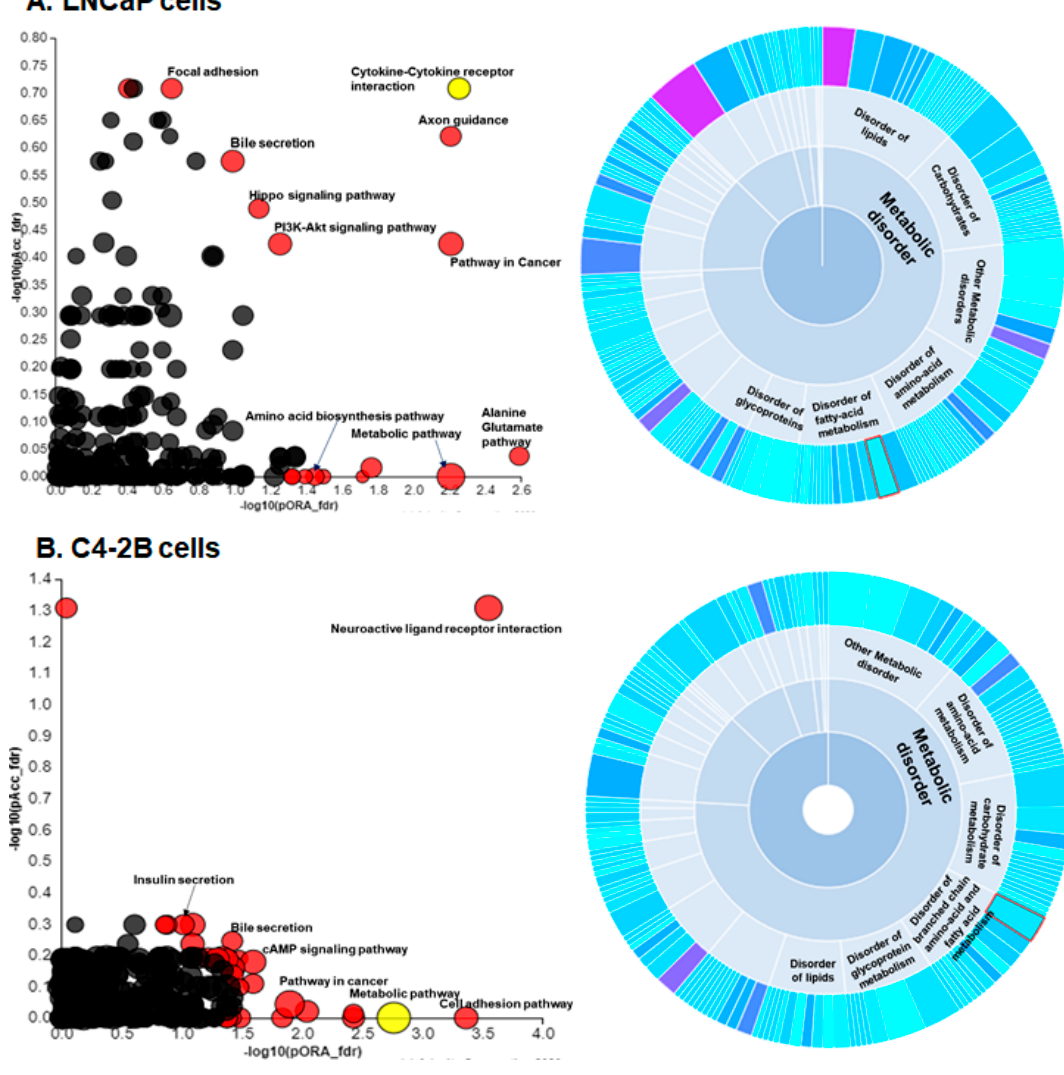
Figure 3. Pathway enrichment analysis of disease association in ( A ) LNCaP enzalutamide resistant cells and ( B ) C4-2B enzalutamide resistant cells compared to their parental counterparts. Overrepresented signaling pathways were analyzed by iPathway. Red color dots represent the pathway after FDR correction and yellow dots represent top hit pathways such as cytokine-cytokine receptor interaction in LNCaP cells and metabolic pathway in C4-2B cells. The colored dots denote the overrepresented pathways with corrected p value (FDR < 0.05) (Left panel). The circular plot displays significantly enriched pathways associated with the disease. Both LNCaP and C4-2B enzalutamide resistant cells exhibited DEGs linked with metabolic disorder. The circular plot of metabolic disease represent the DEGs genes overlaid with International Classification of Diseases, Tenth Revision (ICD-10). The metabolic disease display color magenta is the most significant and cyan is less significant (right panel).